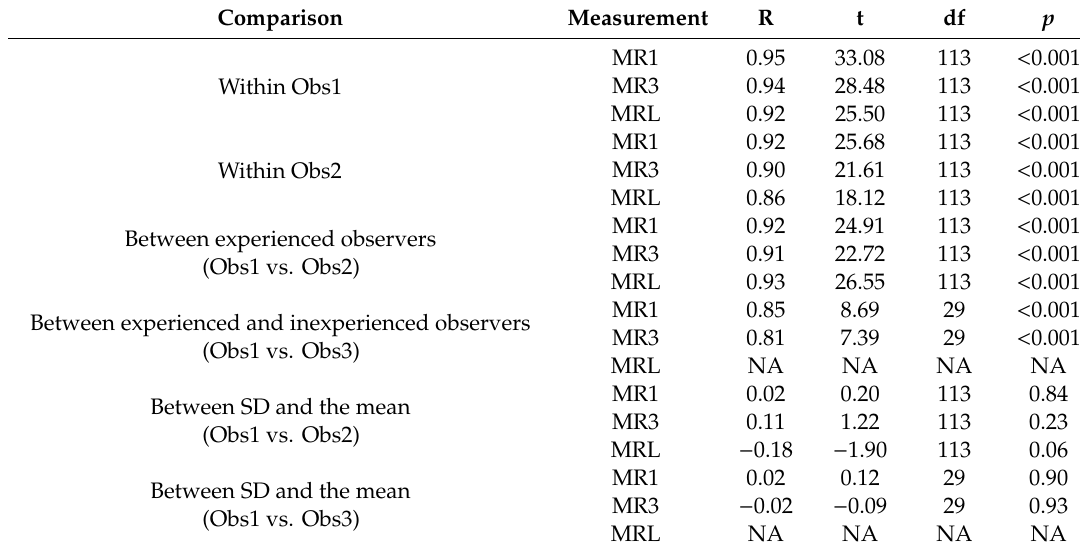
Correlations between replicate measurements within and between experienced and inexperienced observers. Inexperienced Obs3 did not make MRL measurements therefore comparisons are not included